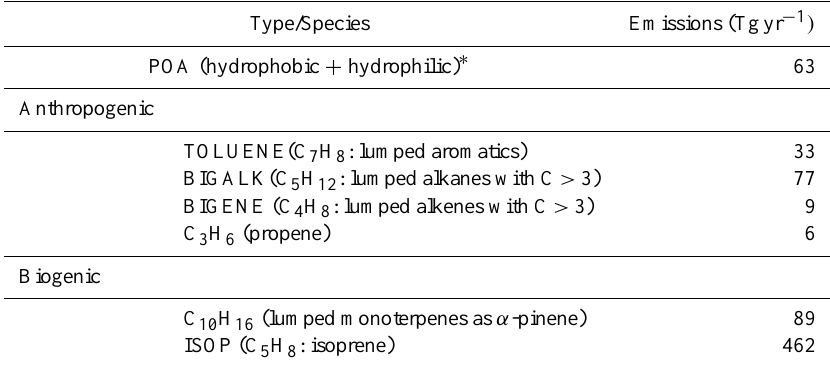
Table 2. Global surface emissions of POA and SOA precursors from anthropogenic and biogenic